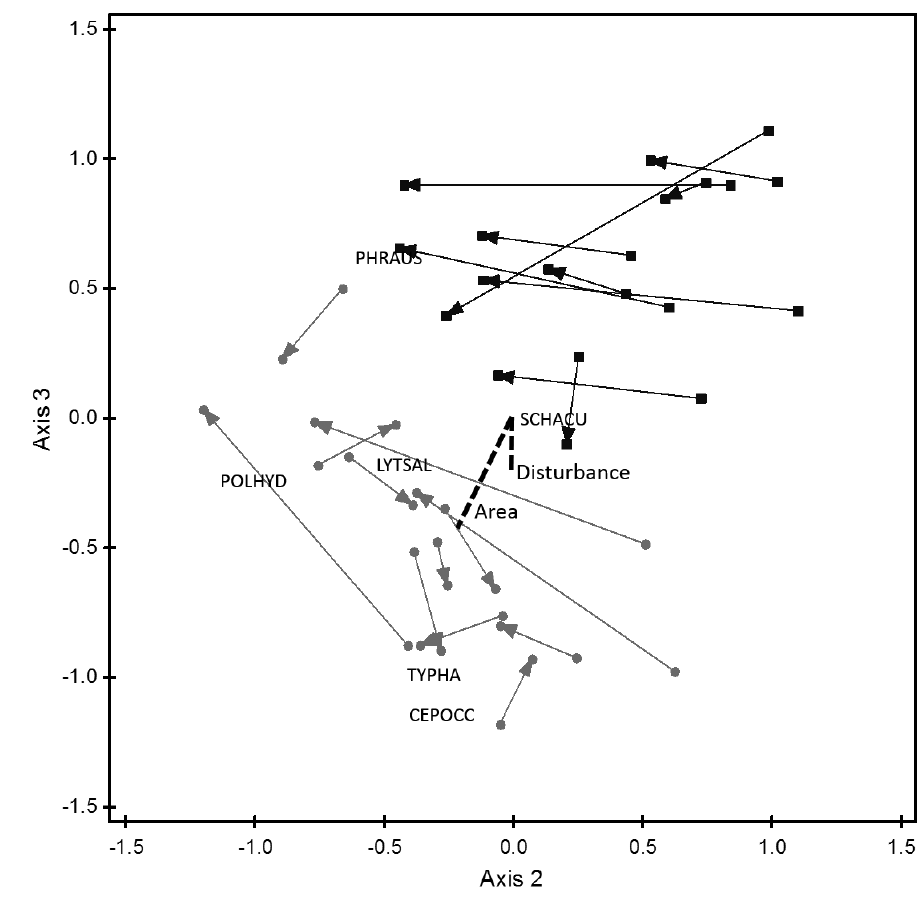
Figure 2. NMDS ordination of 22 sites in two time periods (1982 and 2010/2011) based on species’ im- portance values. Grey symbols and arrows represent “old” ponds, black symbols and arrows indicate “young” ponds. Arrows pair the same site in two time periods, the arrowhead indicates the later (2010/2011) sample. Dashed lines indicate biplots of variables with r >0.300. Species centroids of invader and monodominant taxa are indicated. PHRAUS: Phragmites australis , SCHACU: Schoenoplectus acutus , LYTSAL: Lythrum salicaria , POLHYD: Persicaria hydropiperoides , CEPOCC: Cephalanthus occidentalis , TYPHA: Typha × glauca .